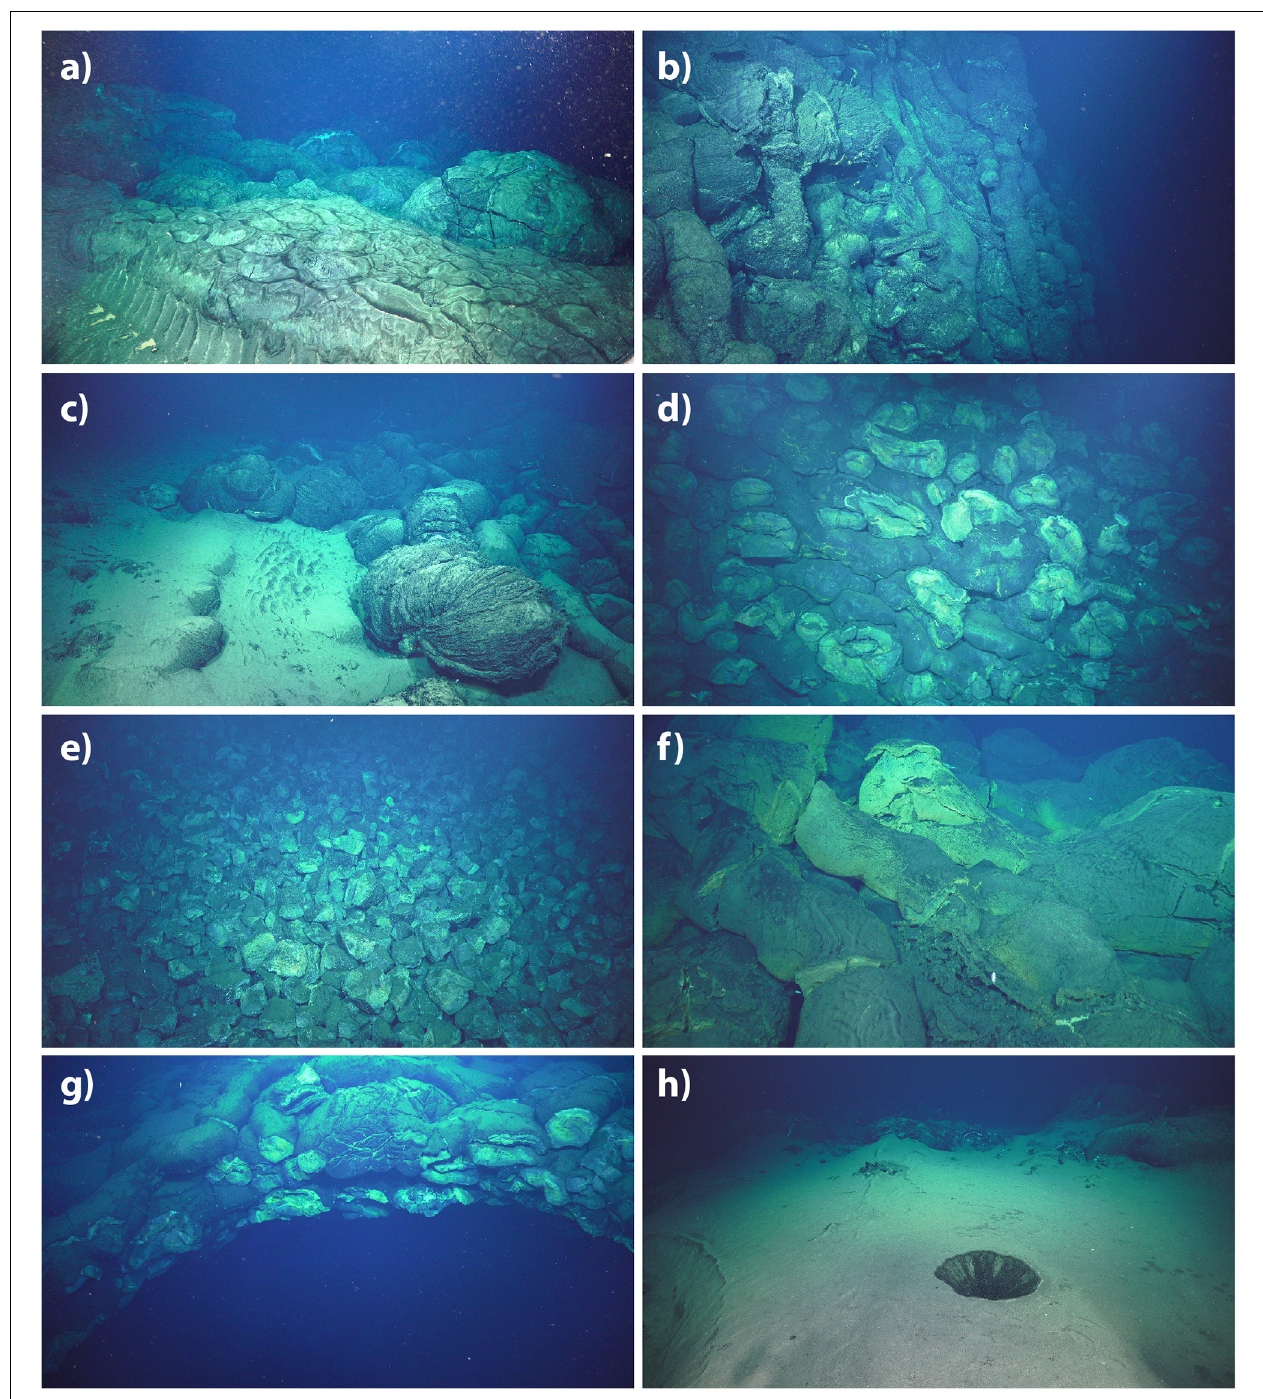
FIGURE 11 | Images of eruption site #3 from ROV SuBastian dive S93. All show 2012–2016 eruption products. Numbers in parentheses are time of photo in GMT and horizontal scale. See Figure 10c for photo locations. (a) Rippled tephra-rich sediment deposited on thin pillow lava flow margin downslope of pillow ridge (21:26:05, 5 m). (b) Nearly vertical constructional slope on upslope side of pillow ridge (23:19:35, 5 m). (c) Margin of young lavas (at right) on upslope side of pillow ridge (22:48:40, 4 m). (d) Truncated pillows in landslide scarp on steeper downslope side of pillow ridge (01:39:25, 8 m). (e) Ramp of pillow talus below landslide scarp on downslope side of pillow ridge (01:33:28, 10 m). (f) Thin yellow hydrothermal sediment and tephra on lavas at top of pillow ridge (00:32:02, 3 m). (g) Overhanging rim of collapse pit at top of pillow mound due to drain-out of molten interior (02:33:15, 4 m). (h) Tephra deposit mantling pillow lavas at upslope end of pillow ridge (02:48:08, 5